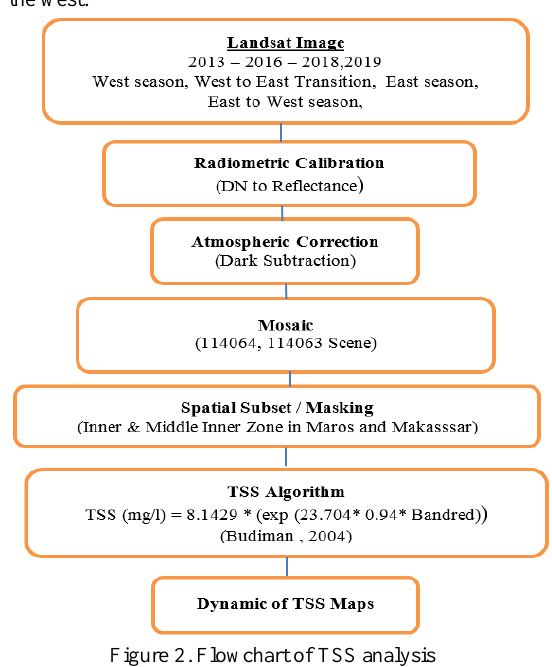
Figure 2. Flowchart of TSS